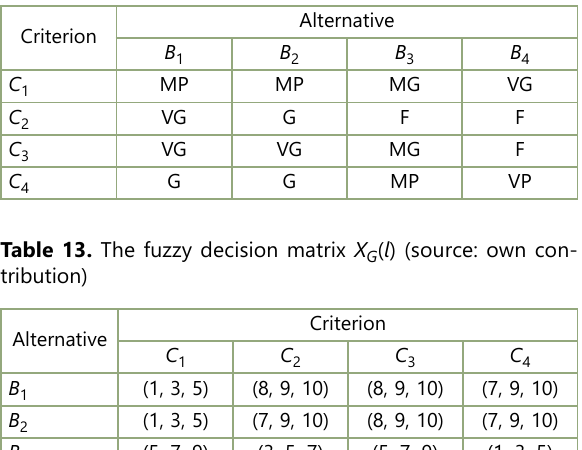
Table 12. Assessment of offers of transport options with the use of fuzzy TOPSIS approach (source: own contribution) Criterion